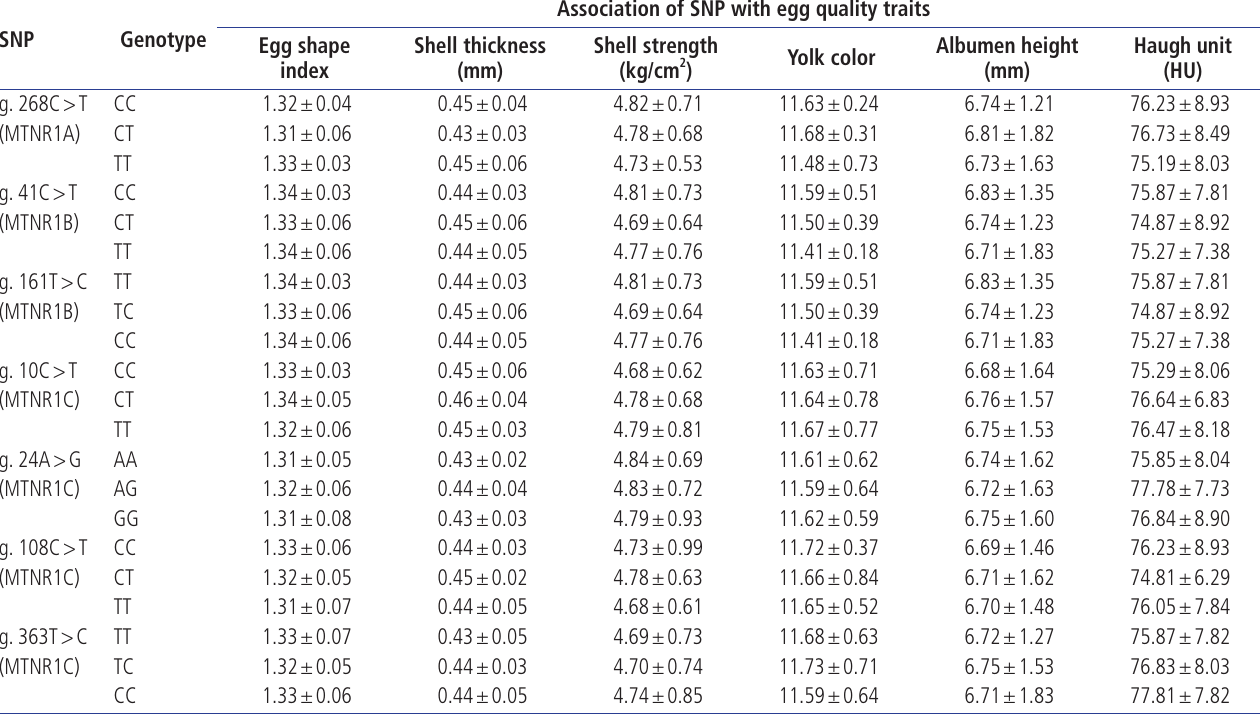
Association of SNP with egg quality